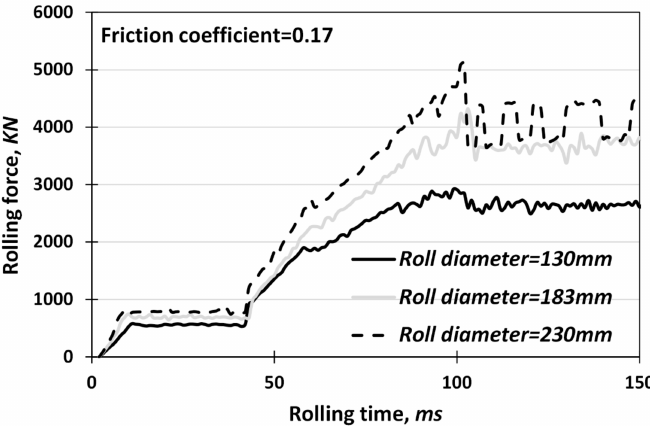
Figure 5. Effect of roll diameter on the rolling force during VGR.